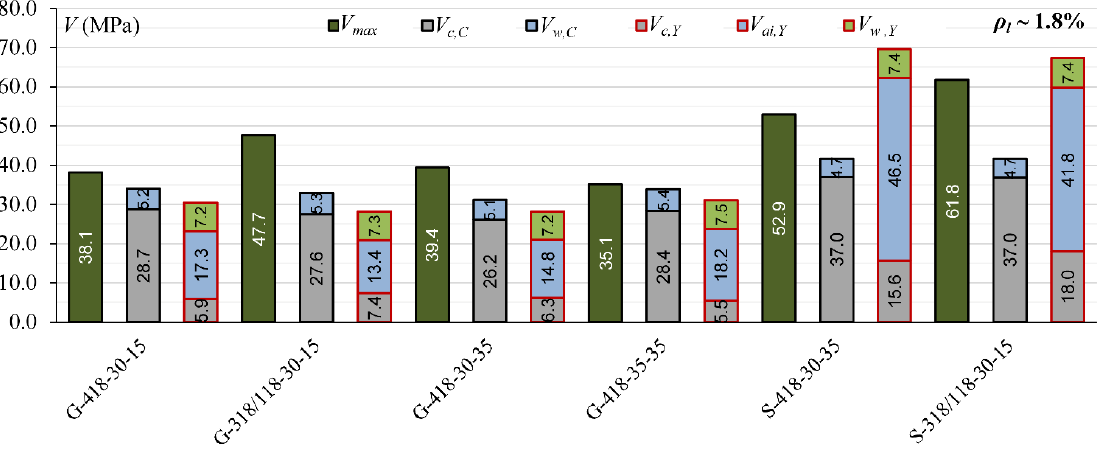
Figure 11. The comparison of shear mechanism contribution for GFRP and steel RC beams with reinforcement ratio ρ l ~ 1.8% for Cladera et al. ’s. and Yang’s models.